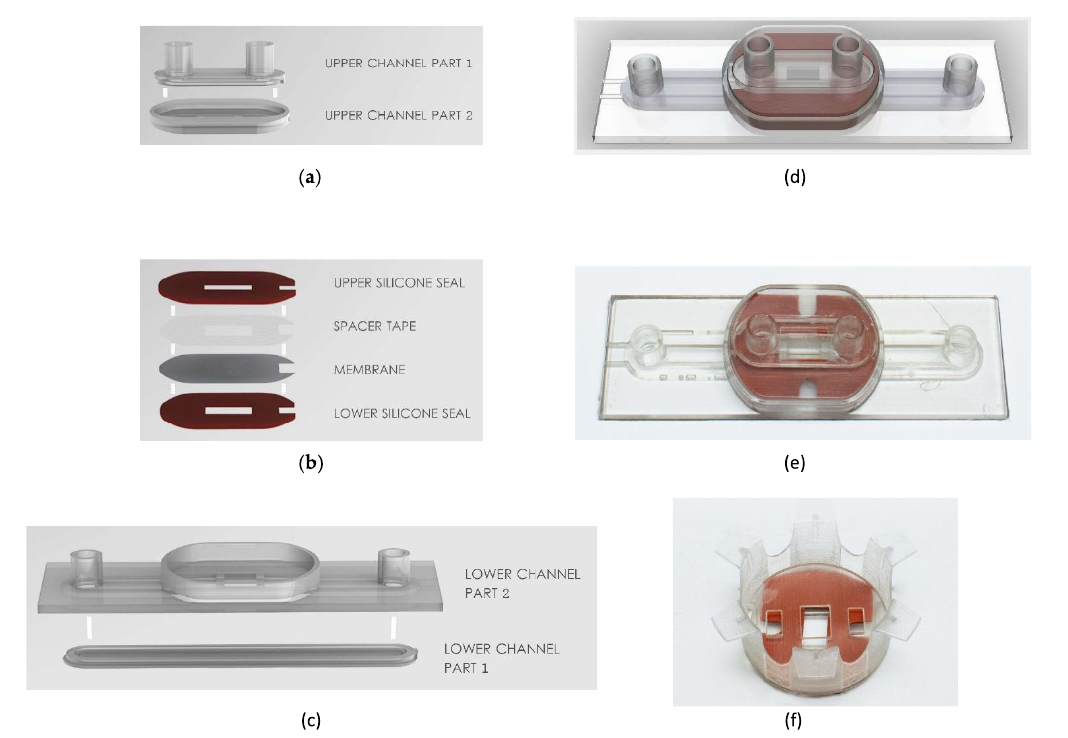
Figure 1. The fabrication process of the TripleB fluidic chip, beginning with the sub-assembly in ( a ) which shows the formation of the upper fluid channel (for endothial cells) comprising two rigid bodies (upper channel part 1 and upper channel 2), which are 3D printed using biocompatible MED610 resin, and are then sealed along the edges using uncured MED610 resin, which is then separately cured with a UV lamp; ( b ) then, the assembly of the removeable membrane is performed, which consists of a porous membrane with 3.0 µm pore size (Oxyphen) and spacer tape to support the delicate porous membrane structure, which are then sandwiched between an upper and lower layer of silicone rubber (Shore hardness 30 A) to ensure a tight seal between the rigid bodies of the upper and lower channels—the shapes of these components were fabricated using mechanical die-cutting and punching and exposed a surface area of 4 × 8 mm or 0.32 cm 2 on either side of the porous membrane for the growth of the endothelial and astrocyte cells; ( c ) the formation of the lower fluid channel (for astrocyte cells) comprising two rigid bodies (lower channel part 1 and part 2). These parts are fabricated and sealed using the same method as the upper channel. These three sub-assemblies are combined together, as shown with ( d ) a render and ( e ) a photograph of the fabricated TripleB fluidic chip. A photograph of the novel transwell insert is shown in ( f ) which comprises the two rigid bodies (the flanged carrier and the cover with bayonet-type connection) and the removable membrane assembly.